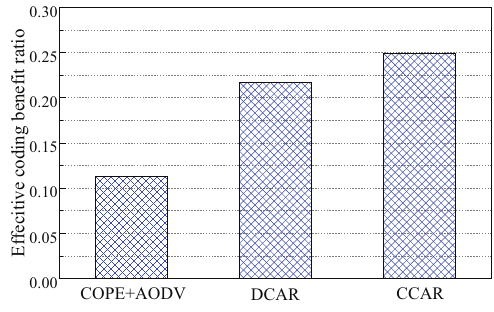
Figure 10. Effective coding benefit